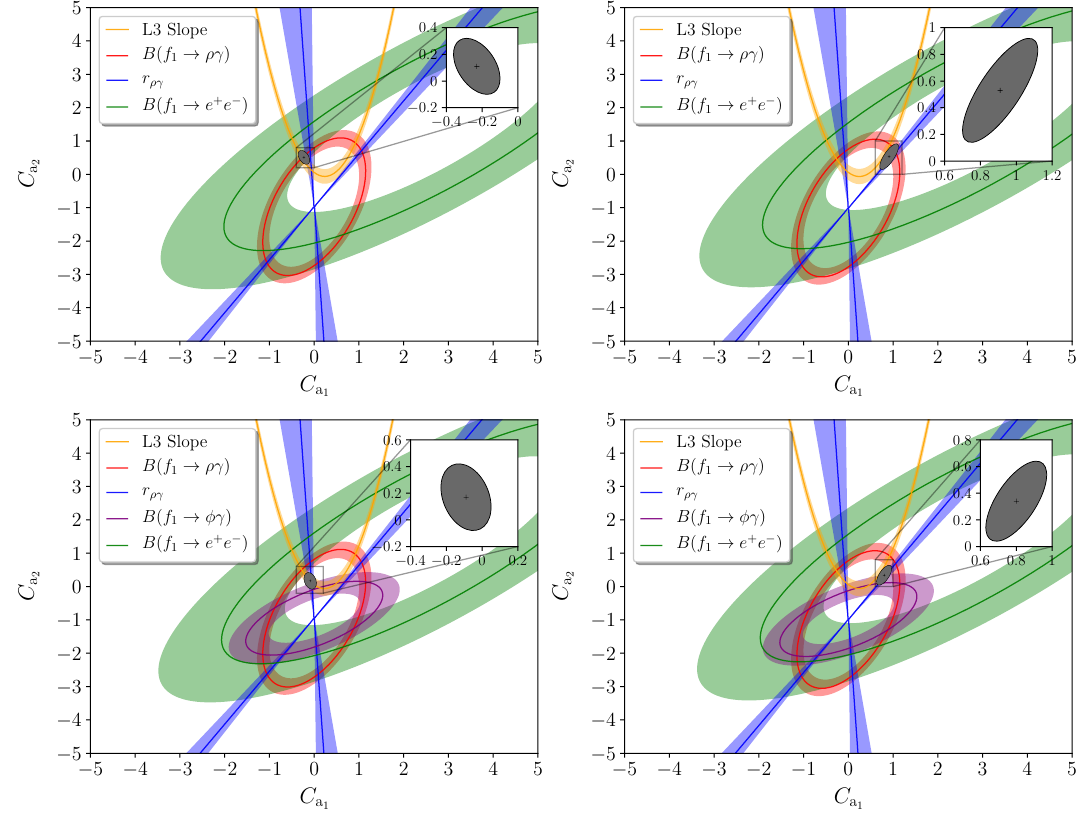
Figure 11 . Contours in the C a – C a plane for the best-fit value of C s in the minimal VMD 1 2 representation: for Solution 1 ( left ) and Solution 2 ( right ), without ( upper ) and including ( lower ) the constraint from B ( f 1 → φγ ) . The best-fit region is indicated by the ∆ χ 2 = 1 ellipse (inflated by the scale